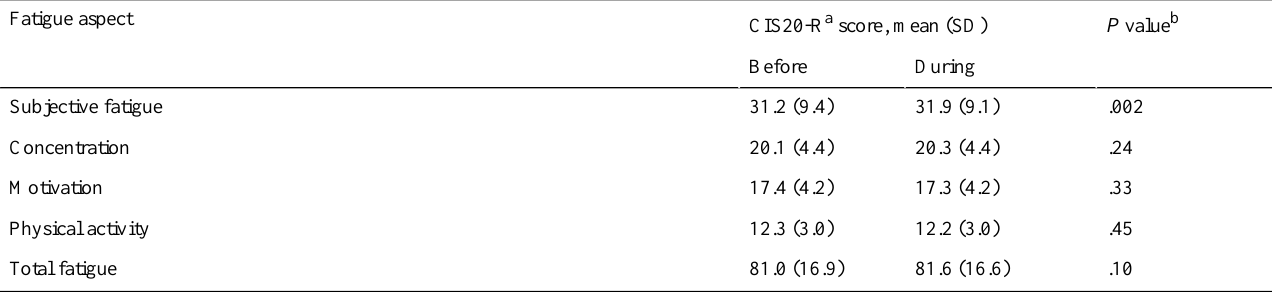
Table 4. Workers’total fatigue and aspects of fatigue before (February 2019) and during (July 2020) the COVID-19 outbreak in Japan